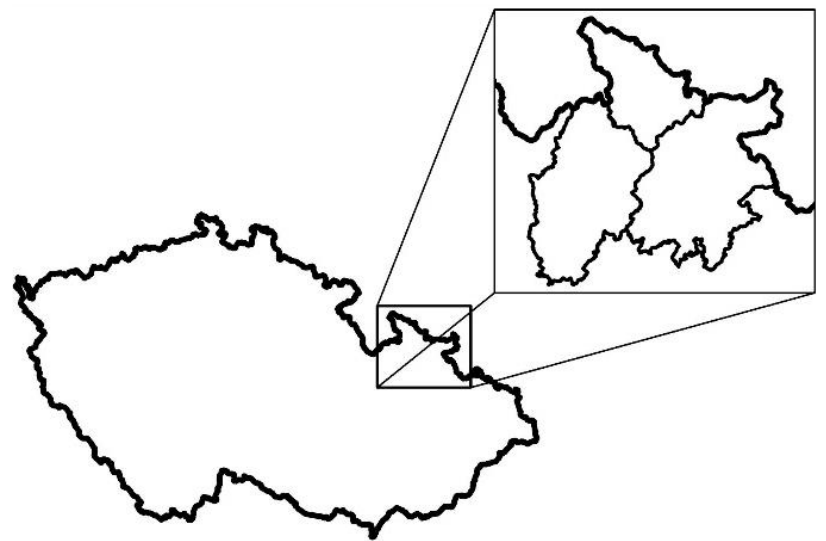
Figure 1. Delimitation of the addressed territory within the Czech Republic.